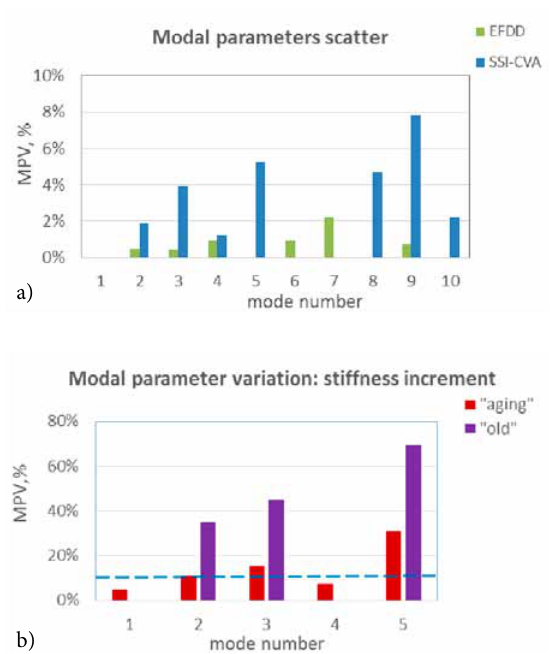
Fig. 6. Modal parameter variation: (a) – scatter between repeated states; (b) – gradual stiffness